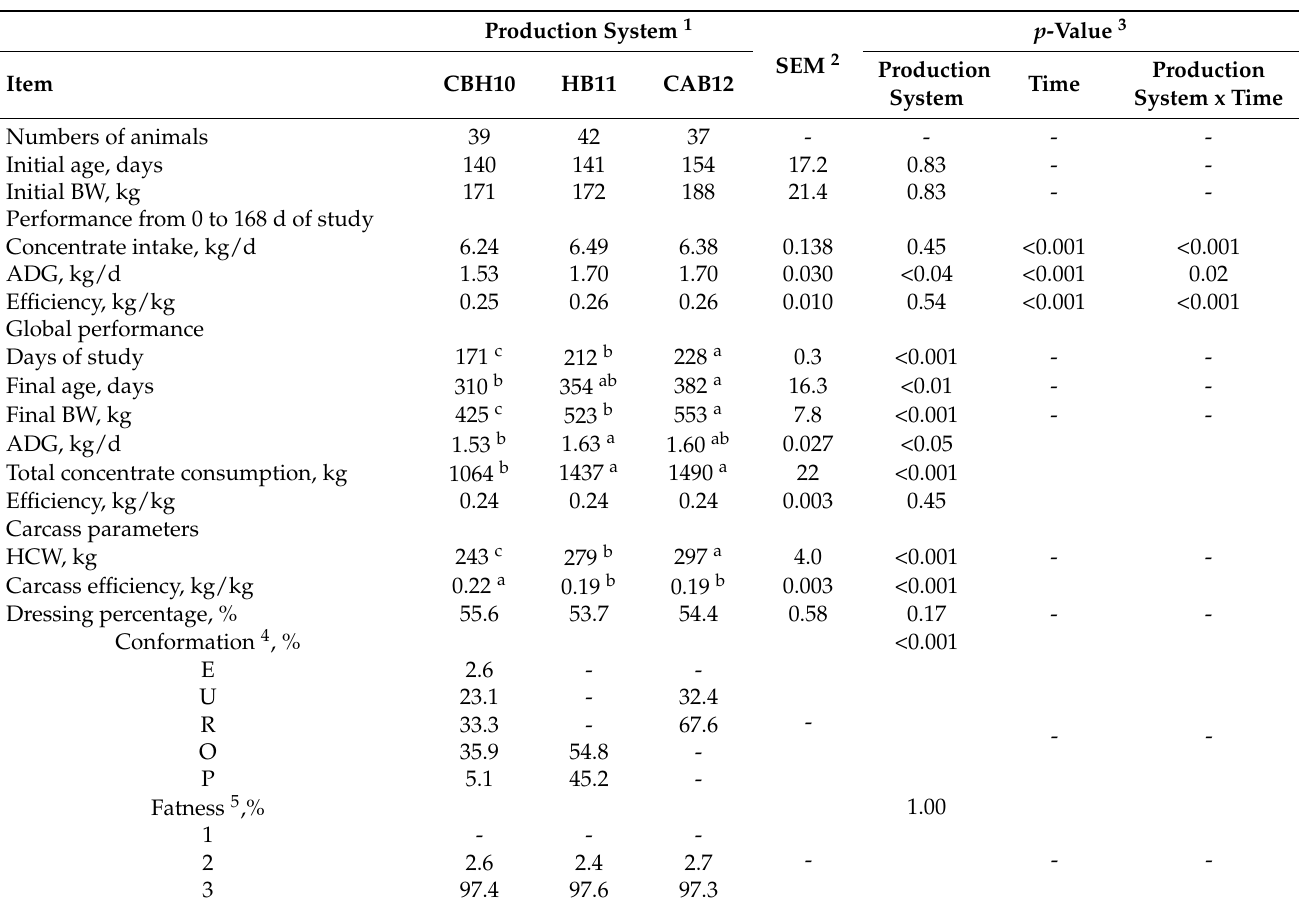
Table 2. Performance and carcass characteristics for the first 168 days and whole study for different Mediterranean beef fattening